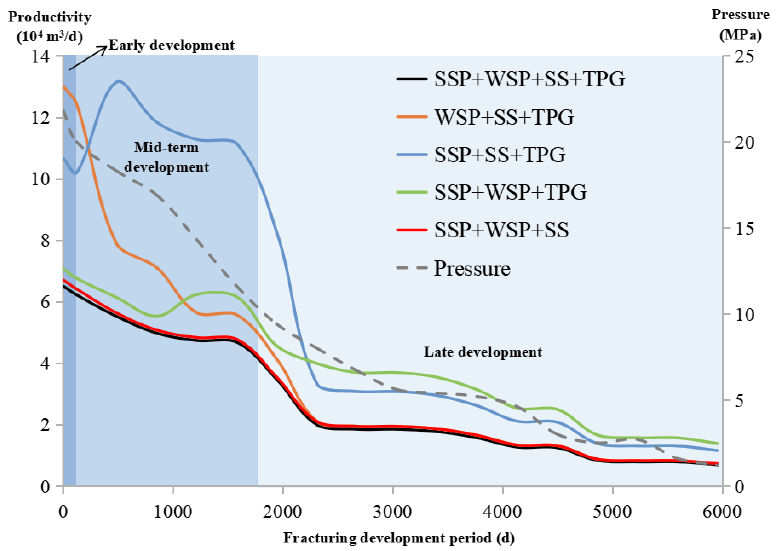
Figure 13. The pollution effect on gas reservoir production under the condition of only threshold pressure gradient pollution.